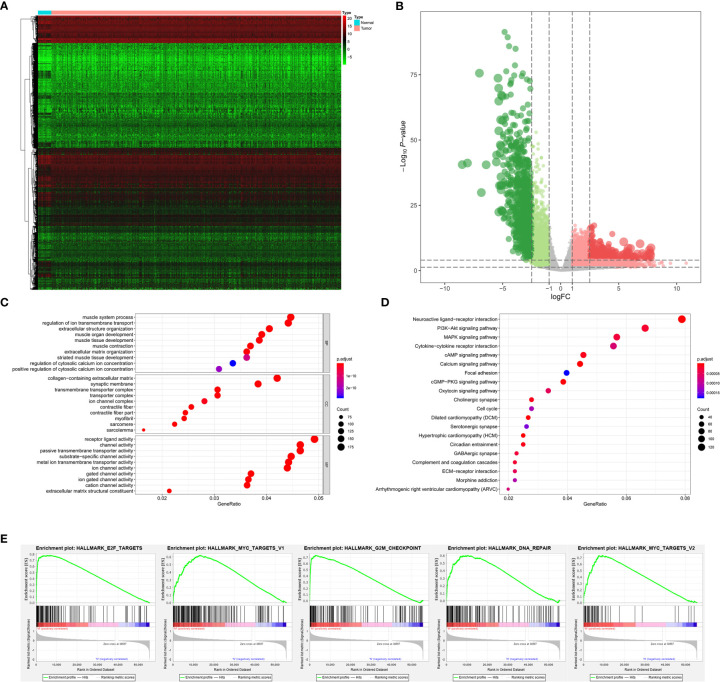
The results of differential expression genes analysis and functional enrichment analysis between primary BLCAs and normal solid tissue samples: The heatmap (A) and volcano plot (B) of the differential expressed genes. The GO (C), KEGG (D), and (E) top five GSEA enriched terms for the differential expressed genes.